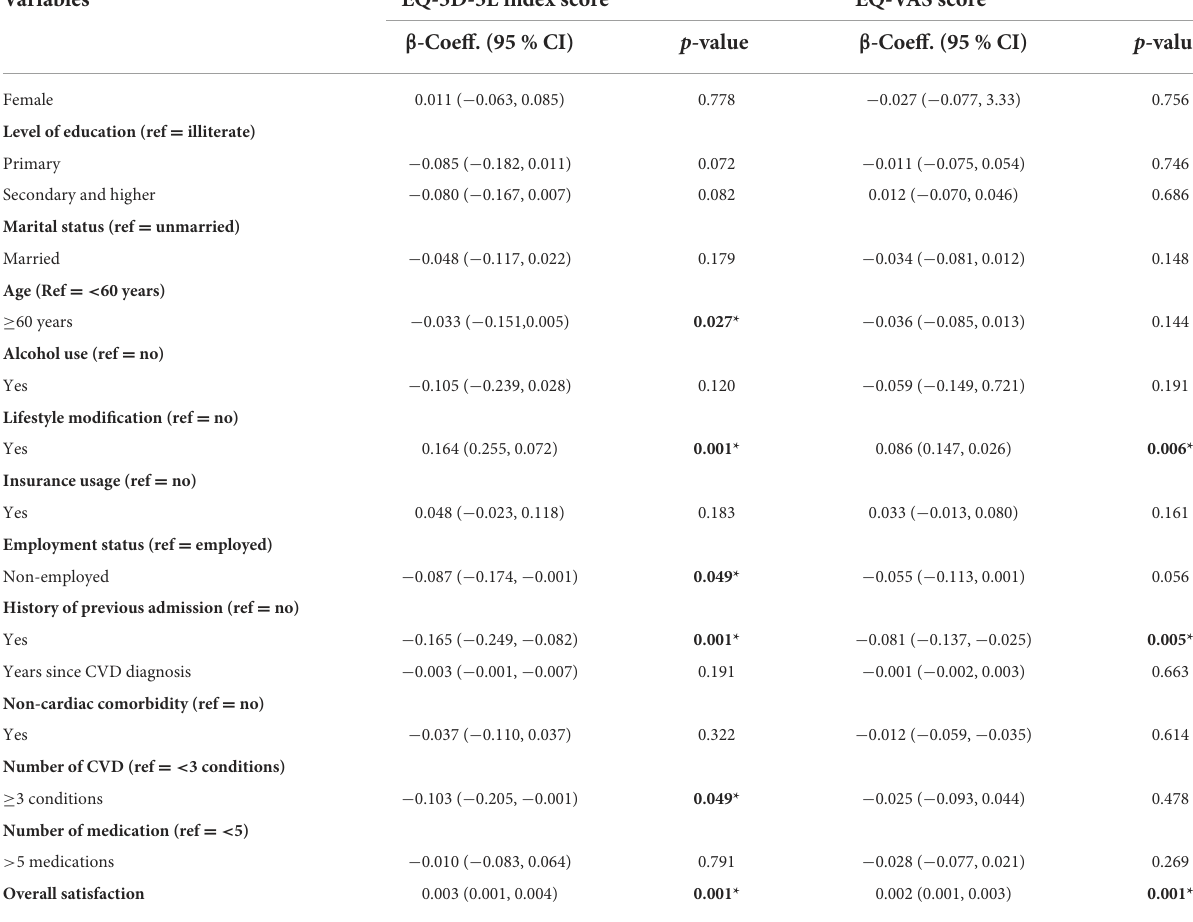
TABLE 5 Predictors of HRQoL in patients with cardiovascular